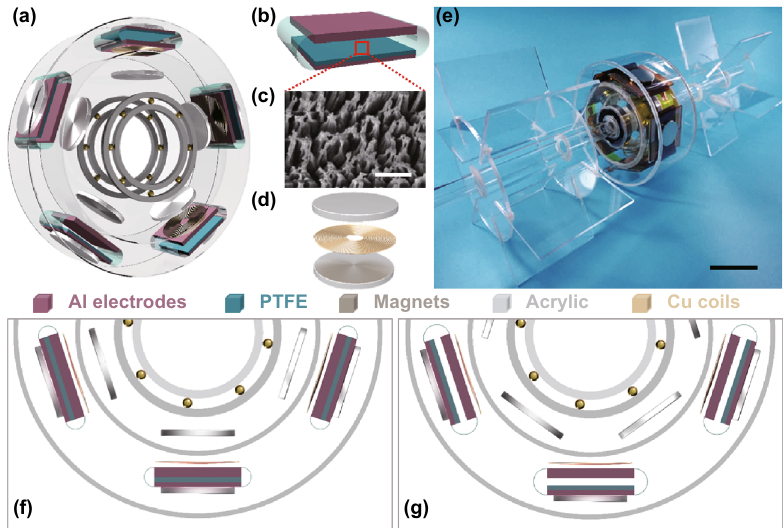
Fig. 1 Structure of the triboelectric–electromagnetic hybrid generator (TEHG). a Schematic illustration of the as-fabricated TEHG, which consists of five contact–separation-mode triboelectric nanogenerators (CS-TENGs) and five rotary freestanding-mode electromagnetic generators (RF-EMGs). Detailed schematic illustration of b a CS-TENG and d a RF-EMG. c SEM image of the polymer nanowires on the PTFE film (scale bar: 1 l m). e Tilted-view photograph of an as-fabricated TEHG (scale bar: 3 cm). Cross-sectional view of the TEHG f when the rotary magnets are aligned with copper coils and g when the rotary magnets gradually move away